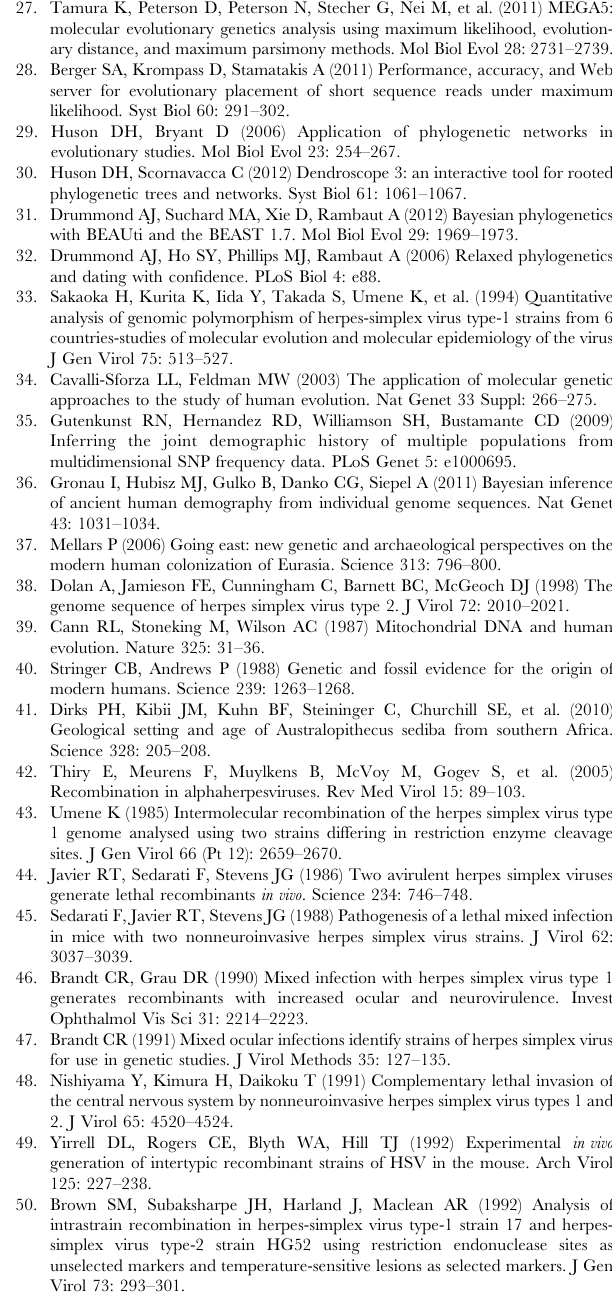
Figure S2 Phylogenetic tree generated by BEAST. Height (95% HPD) bars are blue with a timescale at the bottom.